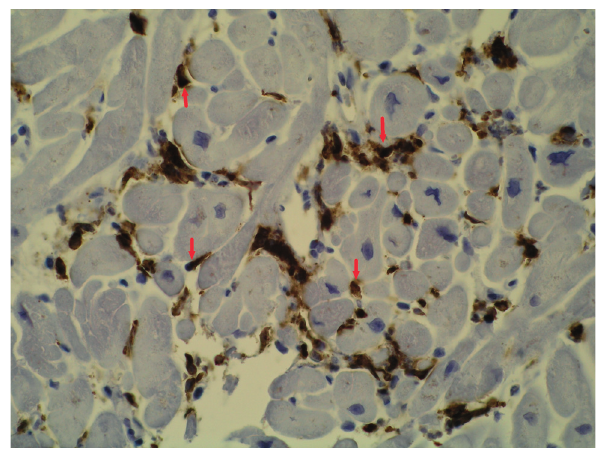
Fig. 1. Mononuclear leucocytes infiltration (LCA+ cells, imu- nohistochemistry, original magnification 200x).